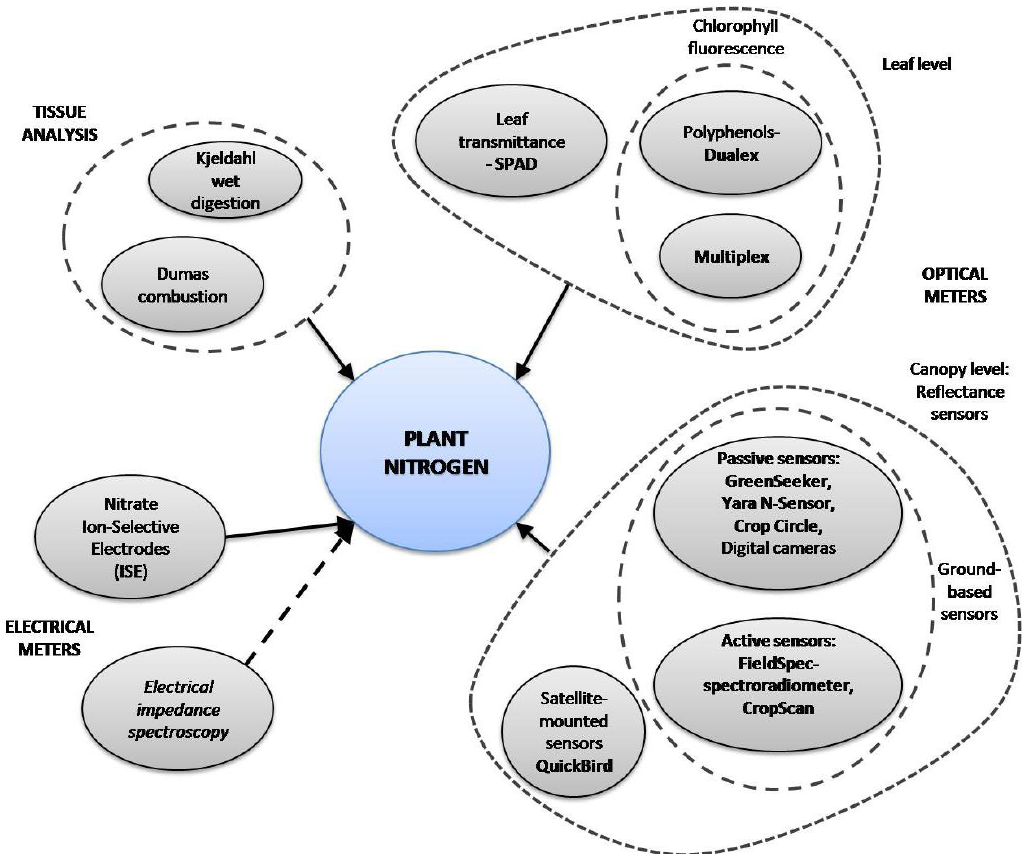
Figure 1. Methods for plant nitrogen